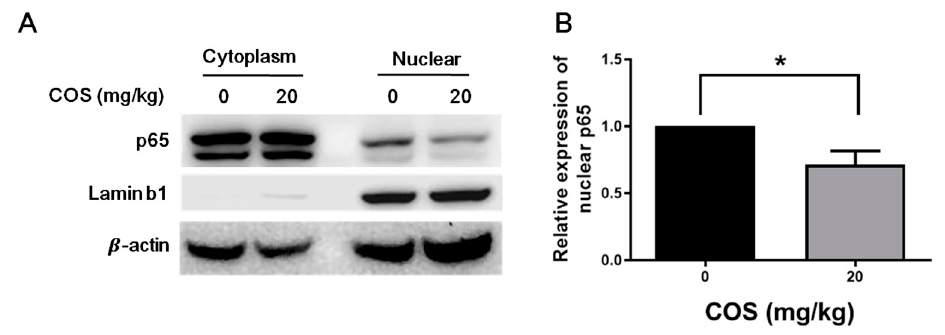
Figure 4. COS inhibits the nuclear translocation of nuclear factor-kappa B (NF- κ B) subunit p65 in the retinas of mice with EAU induction. Mice were treated with or without COS (20 mg / kg) for 21 days and assayed for the nuclear and cytoplasmic fractions of NF- κ B subunit, p65, β -actin and lamin b1 (nuclear marker) by Western blotting. ( A ) The representative blots and ( B ) quantitated results are shown. The nuclear p65 / β -actin value of the retinas without COS treatment was set as 1. Data show the means ± SE values (error bars) of 4 samples per group. * p < 0.05.